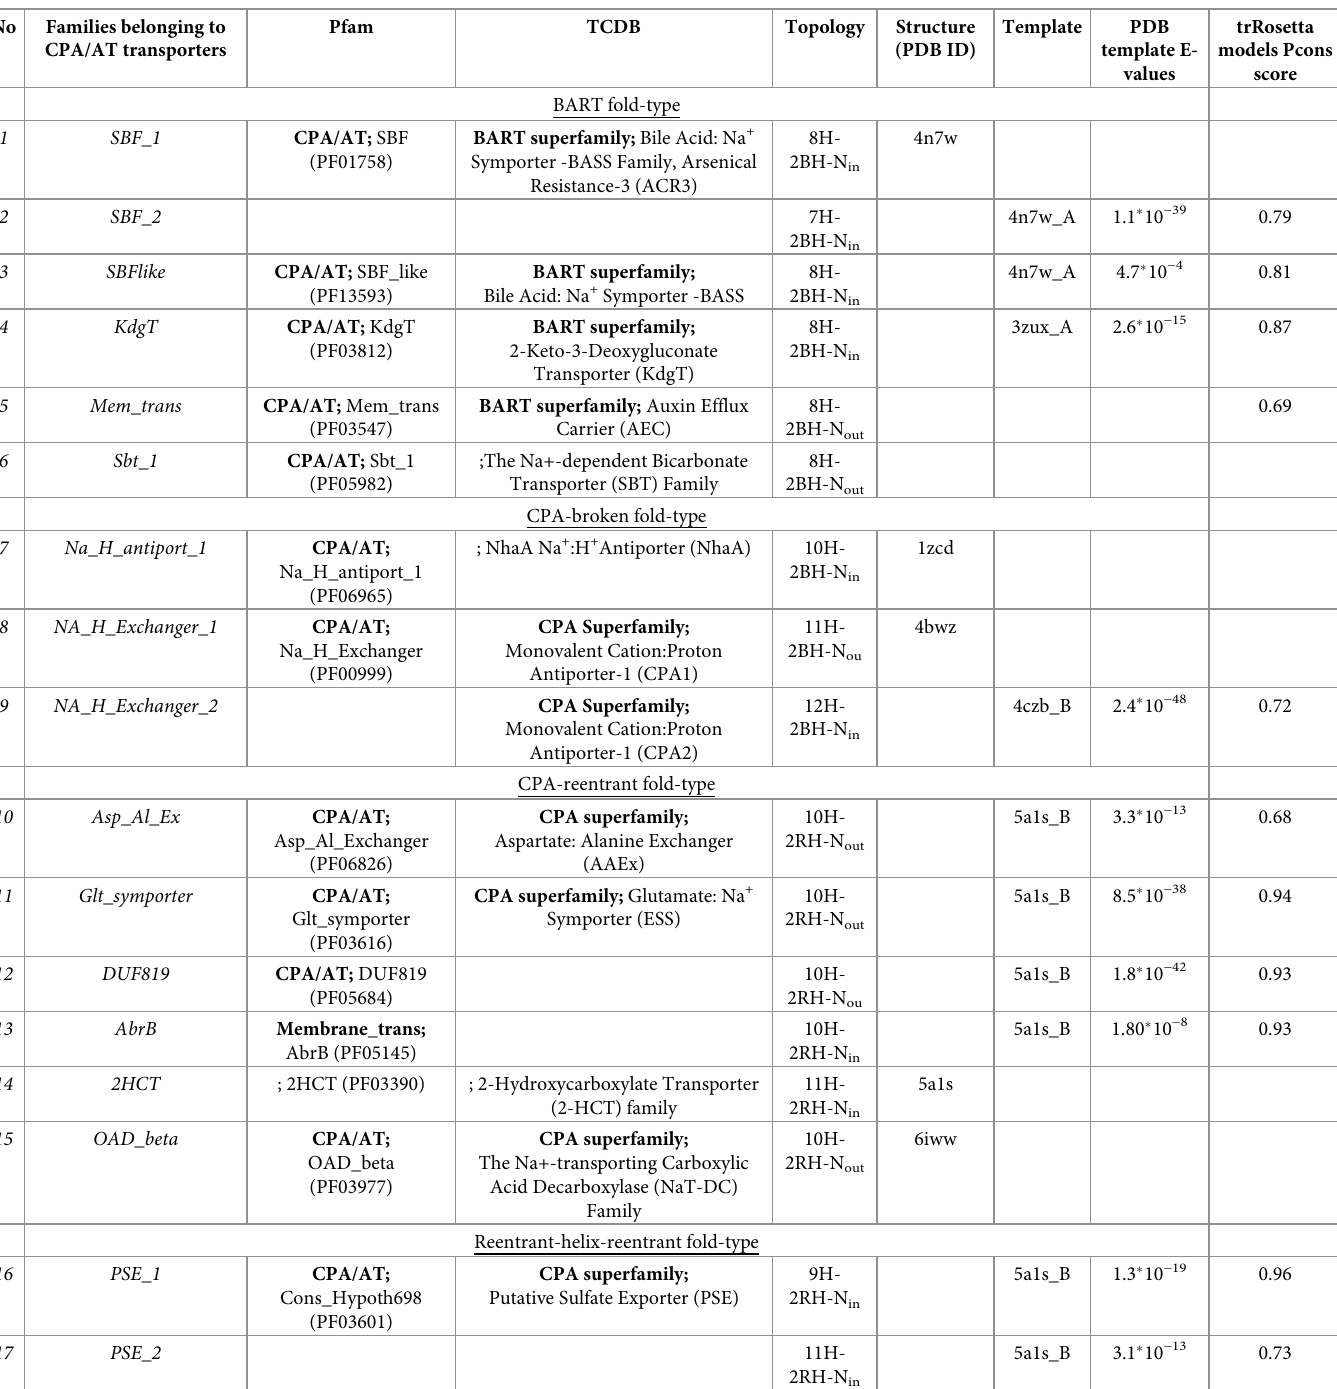
Table 1. Annotation of topology and subdomains for families in the CPA/AT transporters. The orientation (N in, N out ) describes the location of the N-termini of the protein. Comparison of classification of families from this work, TCDB and Pfam are shown. The name in bold preceding the semicolon denotes superfamily, the name fol- lowing the semicolon denotes the family. Families with unassigned superfamily start with a Semicolon. H, RH and BH indicate transmembrane helix, Reentrant helix and Broken helix respectively. When a homologous template was found with an E-value better than 1 � 10 − 3 it was shown. The Pcons scores for the trRosetta models are also